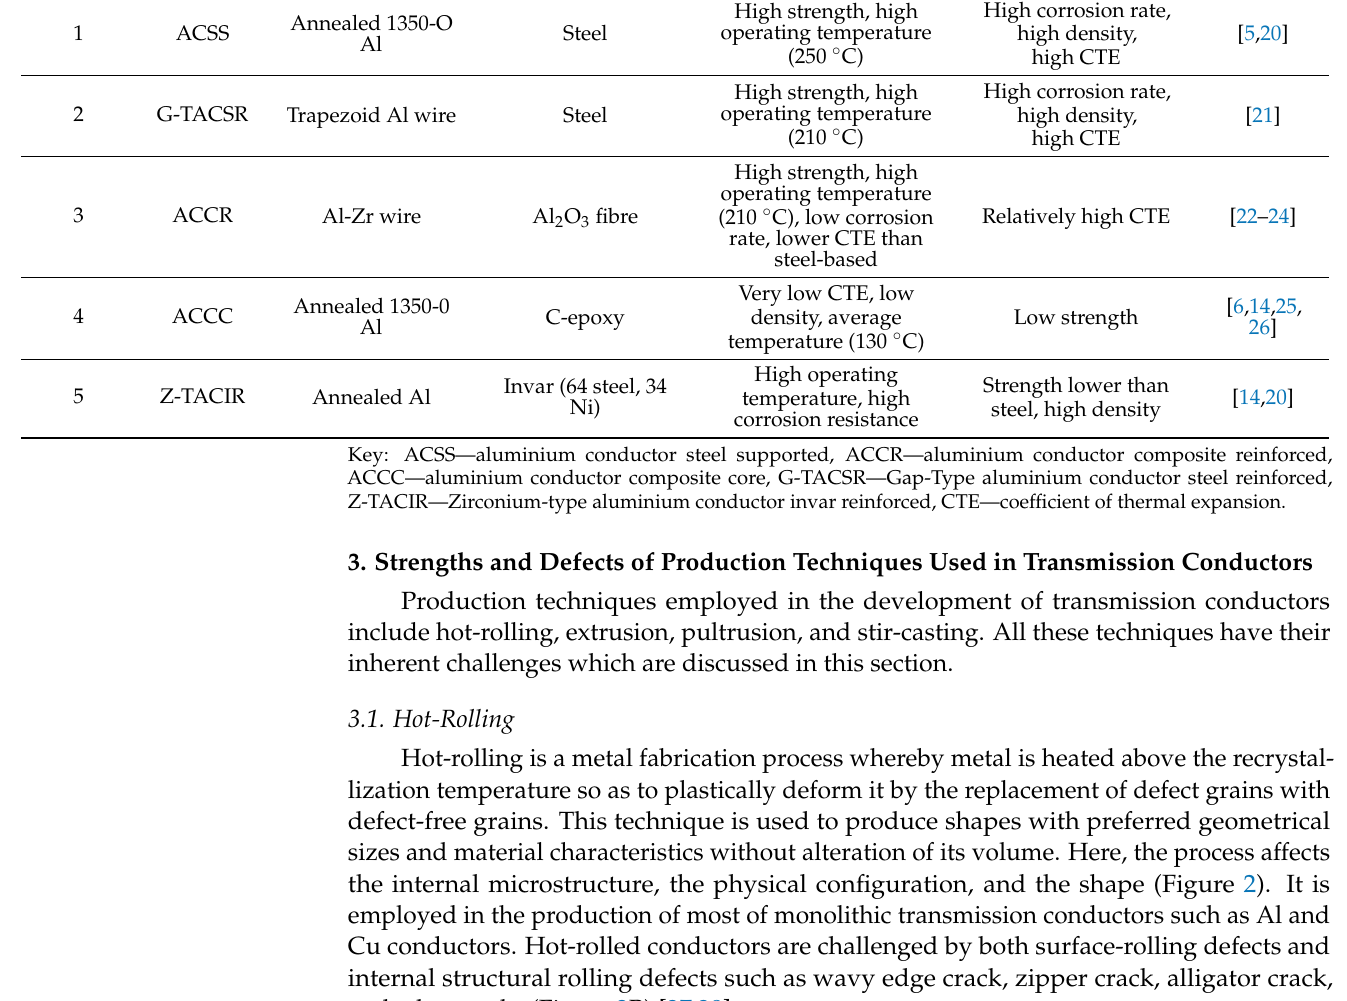
Table 1. HTLS Conductors and their Properties.